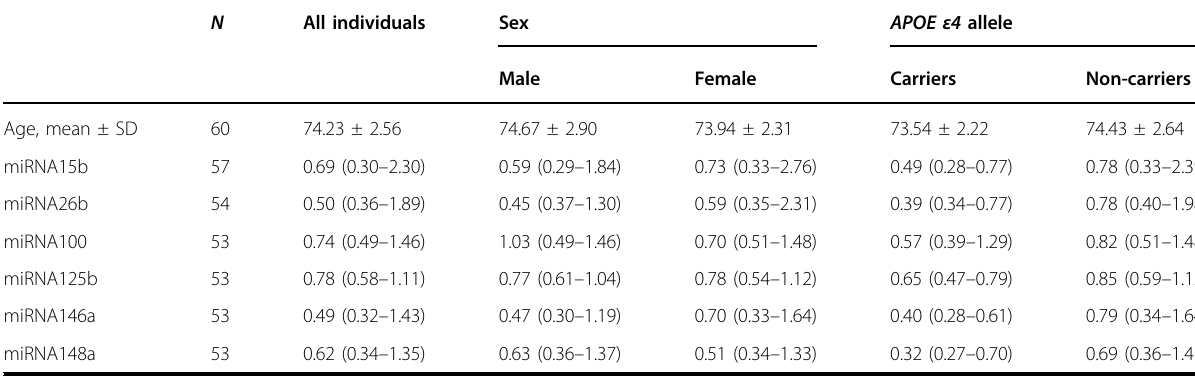
Table 1 Sociodemographic features, APOE ε 4 allele frequencies, and plasma concentrations of the six identi fi ed brain- enriched miRNAs.